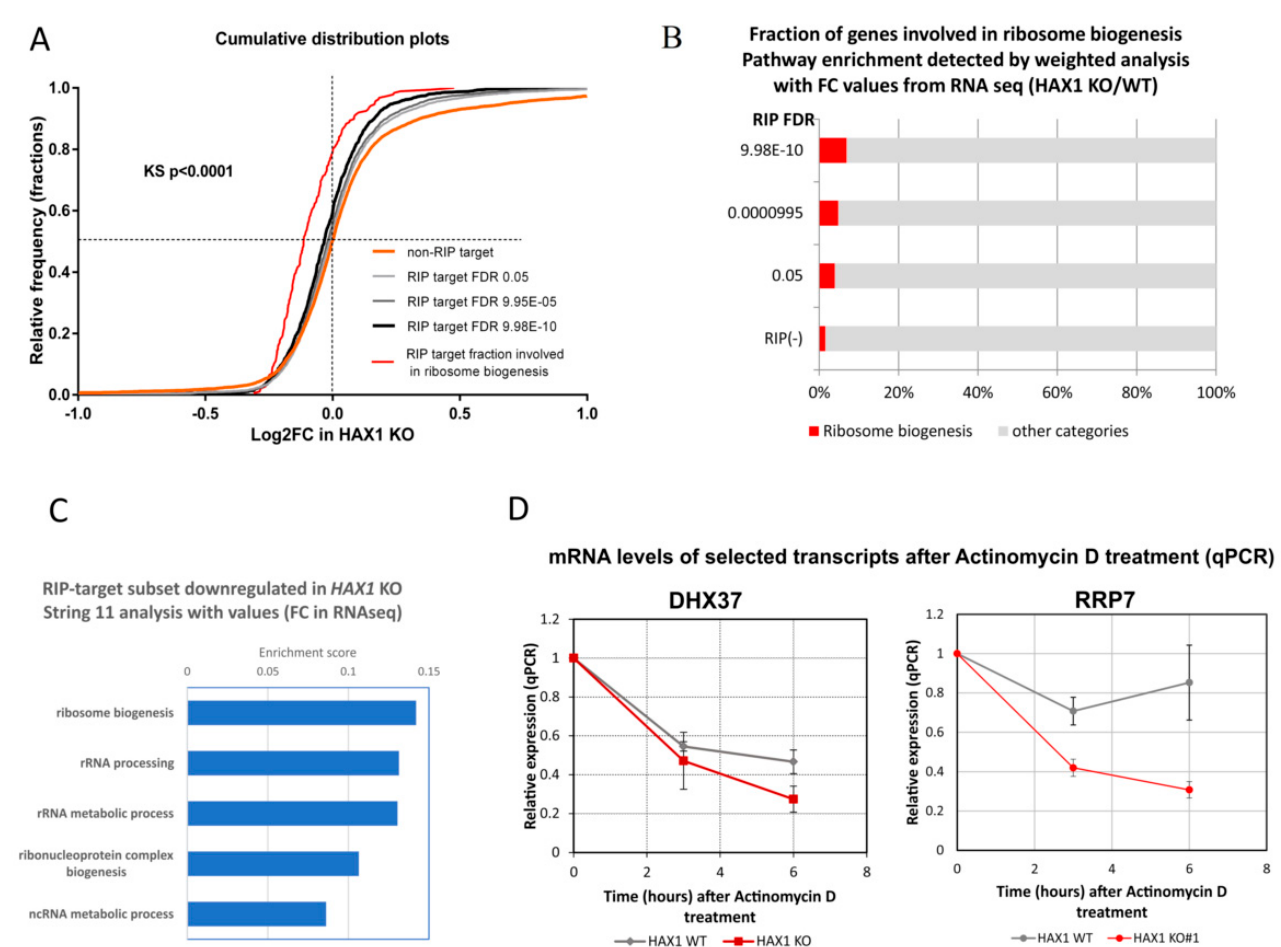
Figure 7. HAX1 binding to RNA targets may be responsible for changes in the expression profile ( A ). Comparison of the distribution of FC changes caused by HAX1 knockout (data obtained in RNA-seq) in the subset of transcripts present between targets identified by RIP (RIP target) and not identified by RIP (non-RIP target). Three different RIP target subsets were compared with cut-offs determined according to the decreasing FDR, showing a shift towards lower FC values (RIP_HAX1/RIP_IgG) in the subsets with lower FDR. Red line: a subset of transcripts involved in ribosome biogenesis, identified by String 11 weighted analysis for RIP-target transcripts (RIP_HAX1/RIP_IgG FC as values). Significance calculated by the Kolmogorov–Smirnov test ( B ). The fraction of transcripts involved in ribosome biogenesis increases with decreasing FDR for the subset of RIP targets. Pathway enrichment calculated in String 11 weighted analysis with FC values from RNA-seq (RNA-seq_HAX1_KO/RNA-seq_WT). ( C ) Enrichment in GO terms assessed by String 11 weighted analysis with FC values from RNA-seq for a subset of downregulated transcripts. Analogous analysis for the upregulated subset produced no results. ( D ) The degradation of DHX37 and RRP7 mRNAs is more dynamic in HAX1 KO cells. Cells were treated with Actinomycin D (10 μ g/mL). Relative expression was quantified by qPCR at designated time points. The experiment was carried out in several biological repeats and evaluated by the t-test (DHX37, n = 4, p -value: 0.026, 6 h, RRP7A n = 3, p -value: 0.035, 3 h). Error bars: SEM.